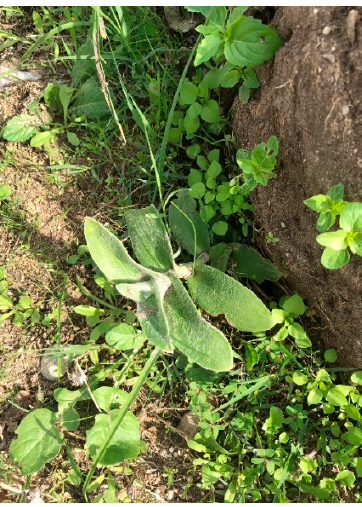
Figure A10. The individual of Tecoma stans (L.) Juss. ex Kunth collected in Bocale (Reggio Calabria province) along the sidewalk of S.S. Jonica 106. ( a ) T. stans and, in the background, the S.S. Jonica 106;